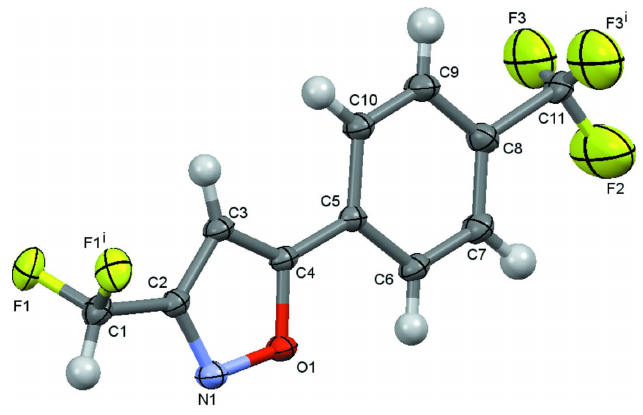
Figure 1 The structure of the title compound, with displacement ellipsoids drawn at the 50% probability level. [Symmetry code: (i) x , y , (cid:4) z + 1